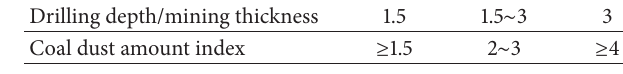
Table 1: Coal dust index for identifying rock burst [22].